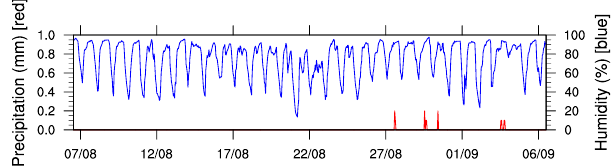
Figure 3. Hourly accumulated precipitation and relative humidity observed at the IAG-USP’s climatological station during the study